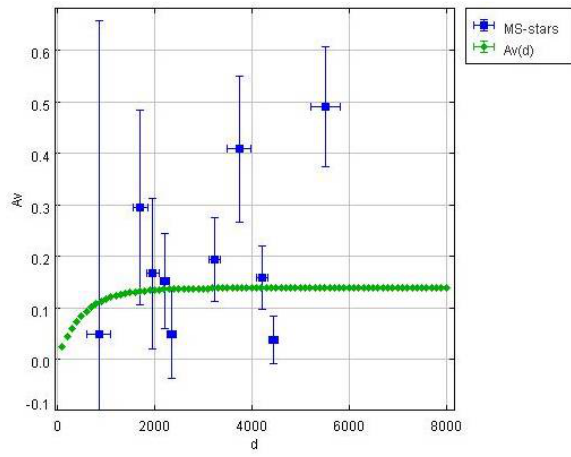
Fig. 2. A V ( d ) relation for area 2 Table 1. Most distant SN data from Perlmutter (1999)